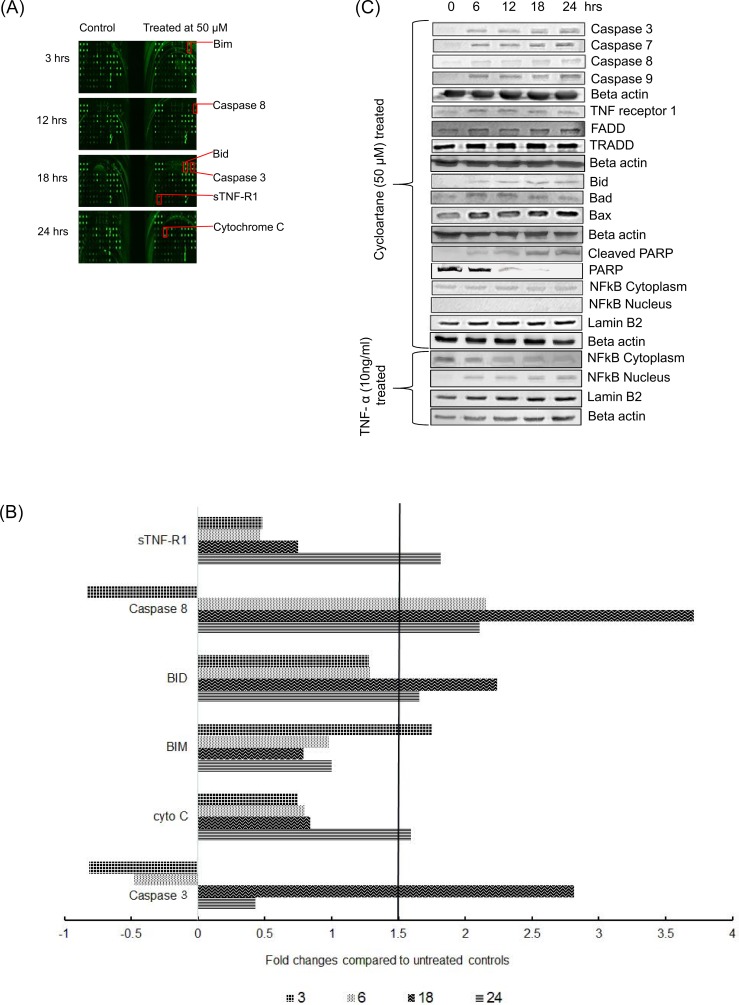
Expression of apoptosis signalling proteins in cycloartane-treated HT-29 cells over various time intervals (6, 12, 18 and 24 hours).(A) Upregulated proteins detected in human apoptosis antibody array. (B) Fold changes of apoptosis signalling molecules in comparison to control with a cut off limit of 1.5 fold. (C) Western blot analysis of apoptotic signalling proteins in cycloartane treated HT-29 cells and TNF-α-treated as positive control for NFkB translocation over various time intervals (6, 12, 18 and 24 hours).